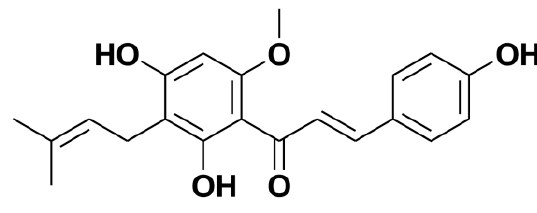
Figure 1. Chemical structure of xanthohumol (XN).